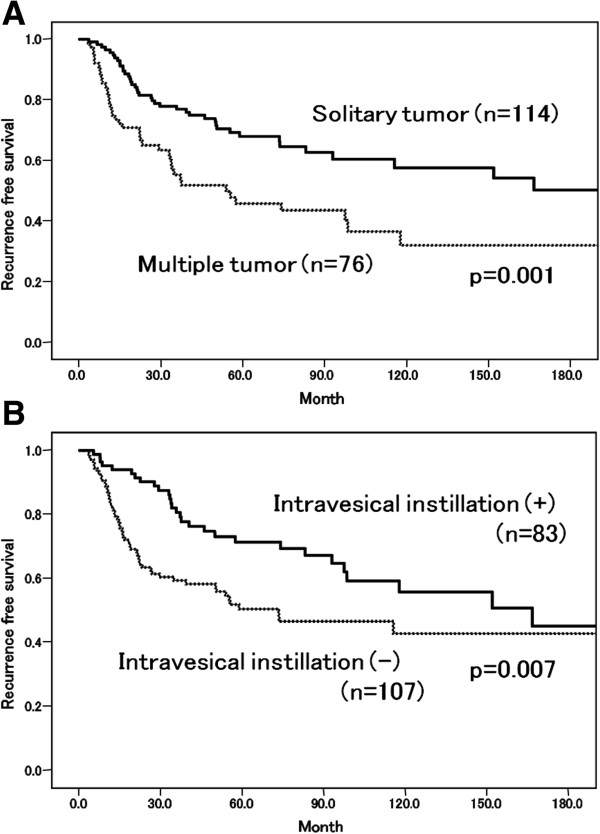
Recurrence-free survival rates (A) by tumor multiplicity, (B) by presense of adjuvant intravesical instillation.